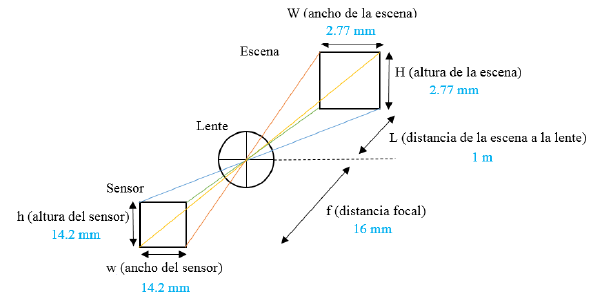
Figure 3. Representation of geometric